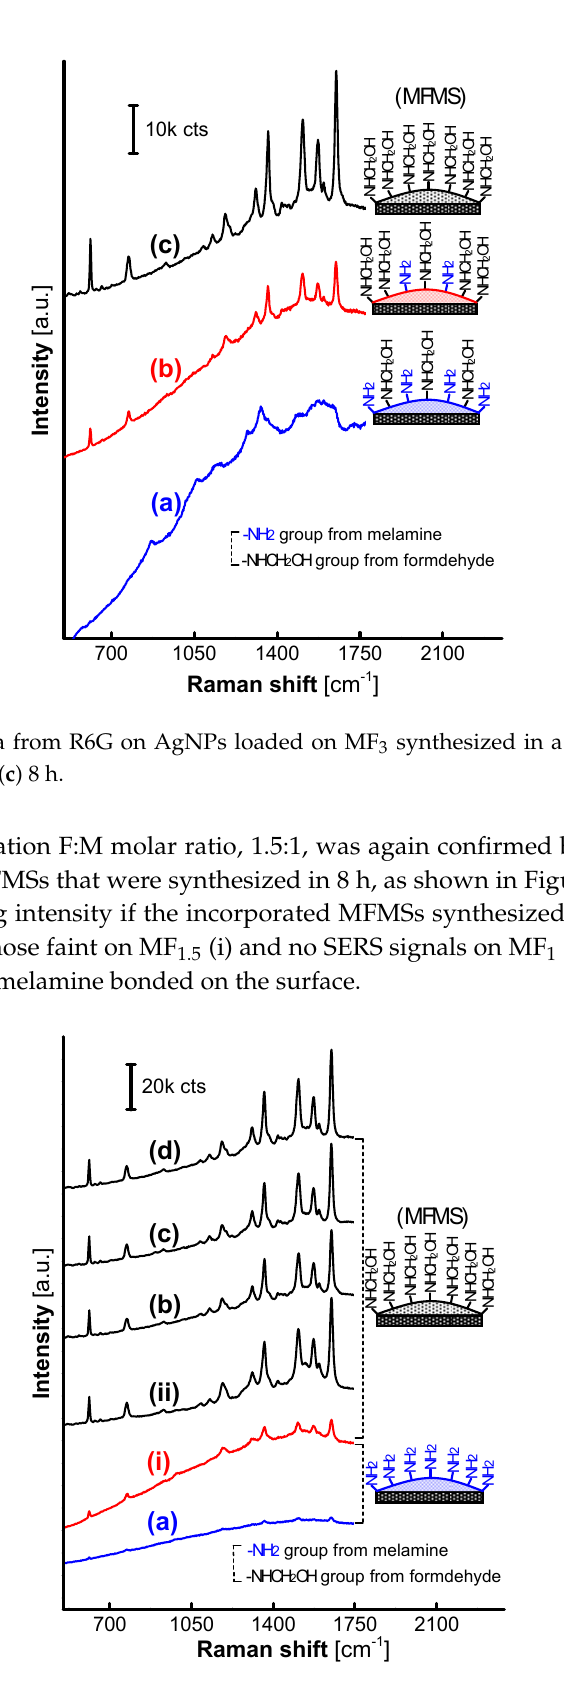
Figure 8. SERS spectra from R6G on AgNPs loaded on MFMSs synthesized with a set of F:M molar ratios in 8 h. ( a ) MF 1 ; ( i ) MF 1.5 ; ( ii ) MF 2 ; ( b ) MF 3 ; ( c ) MF 7 ; and ( d ) MF 9 .